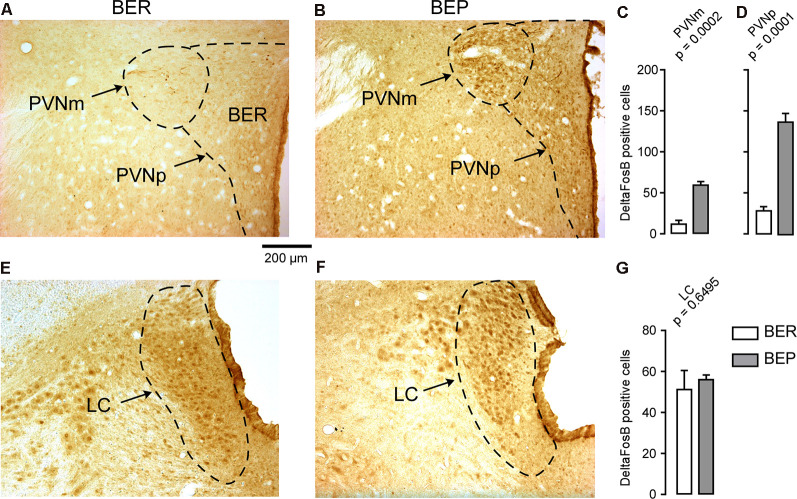
ΔFosB expression in neurons in stress processing regions. (A,B) Images showing ΔFosB-expression in neurons in the magnocellular and parvocellular parts of the paraventricular nucleus of the hypothalamus (PVNm and PVNp, respectively) of BEP and BER rats. (C,D) The number of ΔFosB-positive cells in the PVNm and PVNp in BEP and BER rats. (E,F) Images showing ΔFosB-expression in neurons in the locus coeruleus (LC) of BEP and BER rats. (G) The number of ΔFosB-positive cells in the LC of BEP and BER rats. Scale bar: 200 μm.